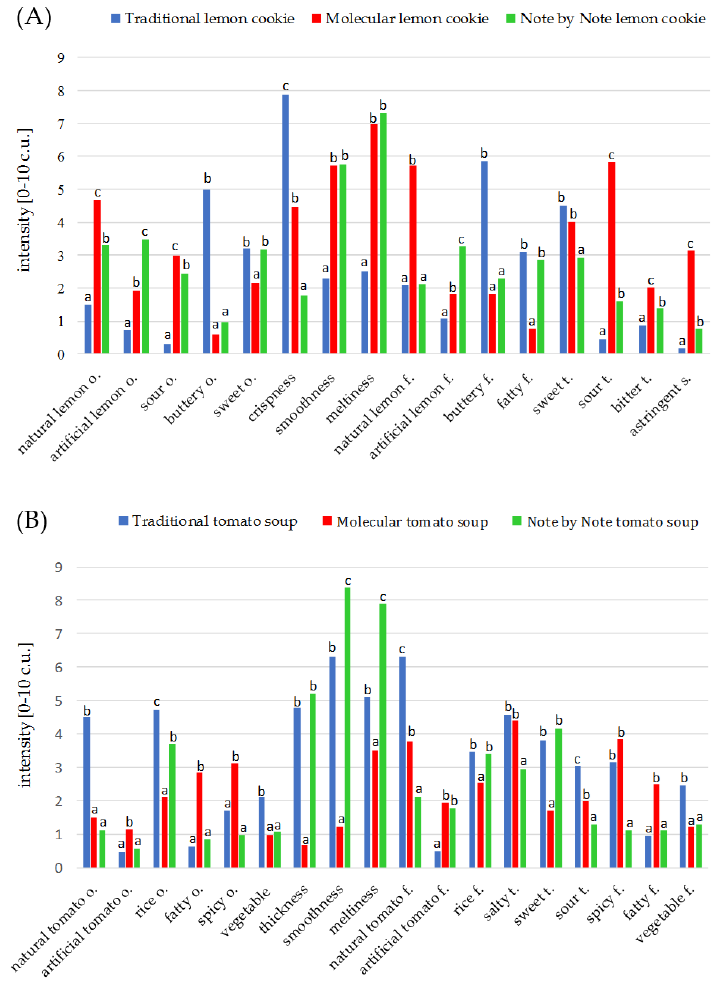
Figure 2. Sensory properties of ( A ) lemon cookie and ( B ) tomato soup that are prepared in traditional, molecular and Note by Note versions: a, b, c—mean values marked by different letters in versions of dishes differ significantly at p ≤ 0.05.